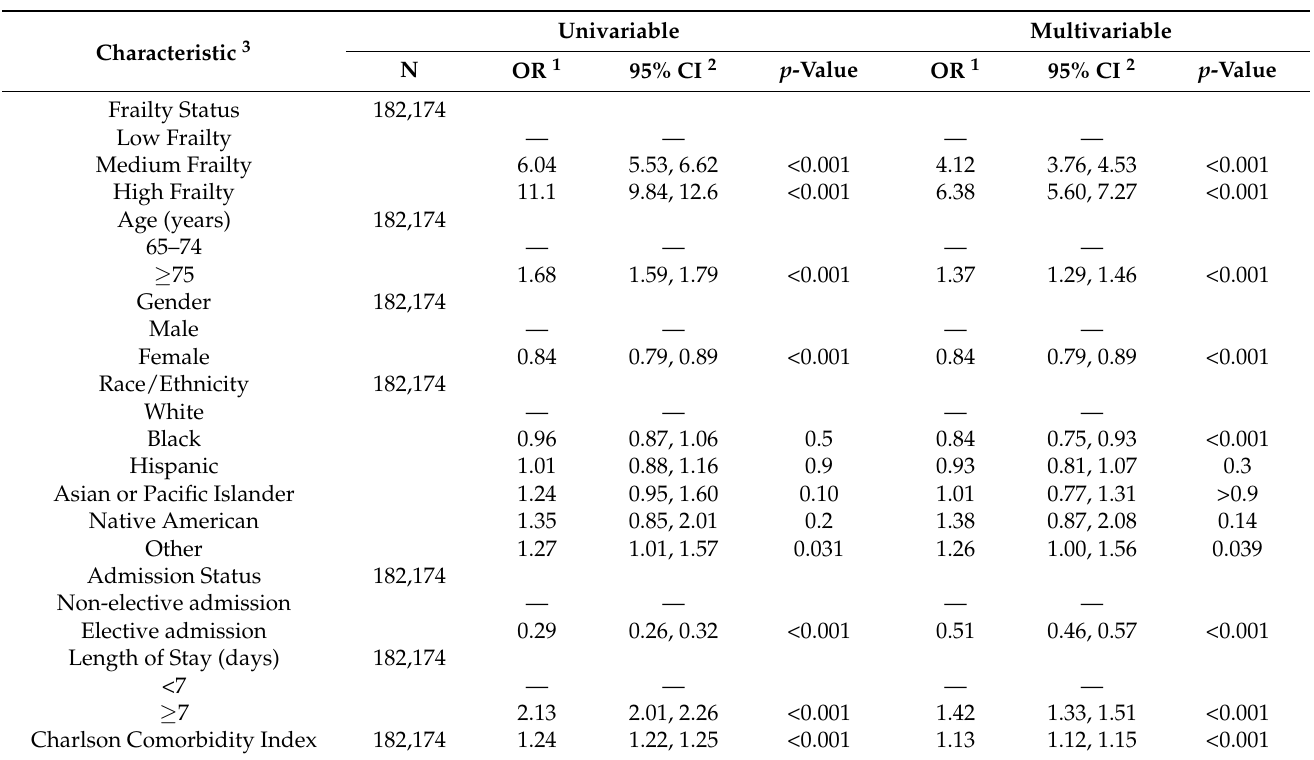
Table 2. Effect of Frailty on Patient Mortality.